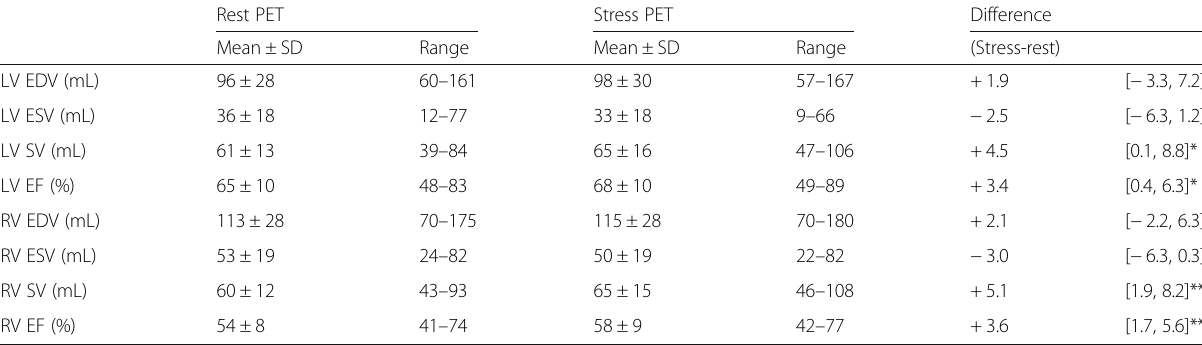
Table 3 First-pass PET estimates of left and right ventricular volume and function at rest and after pharmacological stress. LV was segmented using a 30% threshold. The bias (difference between stress and rest value) is given along with its 95% confidence interval Rest